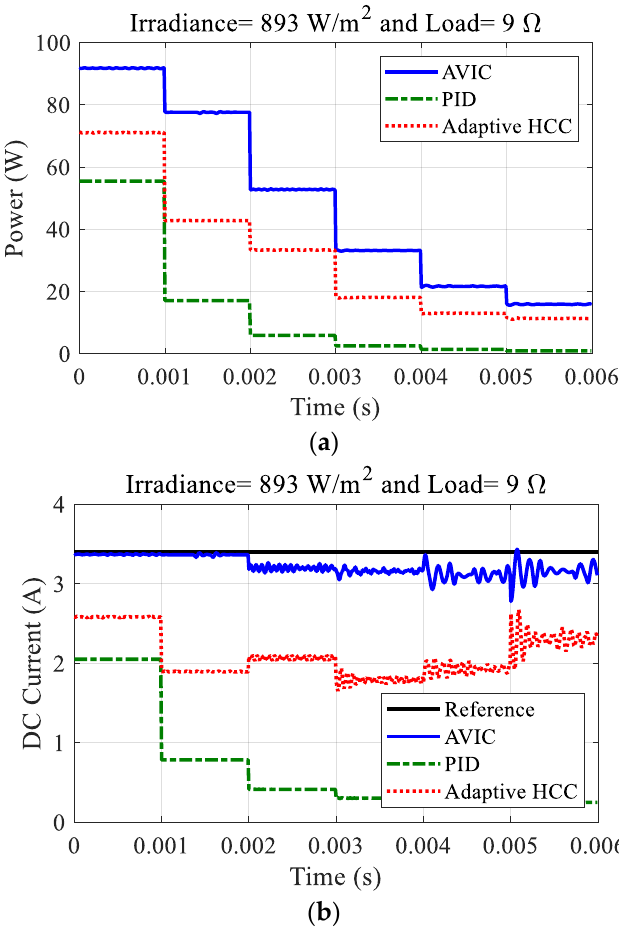
Figure 19. Comparison among three controllers under various distances and at 893 W/m 2 : ( a ) power transfer capability, ( b ) DC current reference tracking.